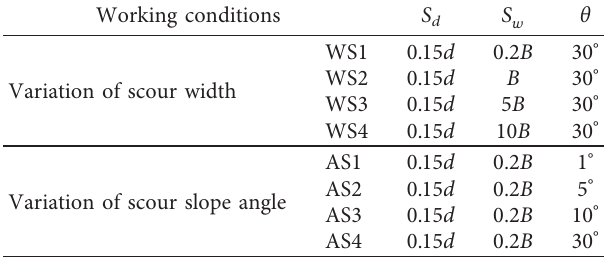
Table 3: Working conditions with scour depth at 0.15 d . Working conditions